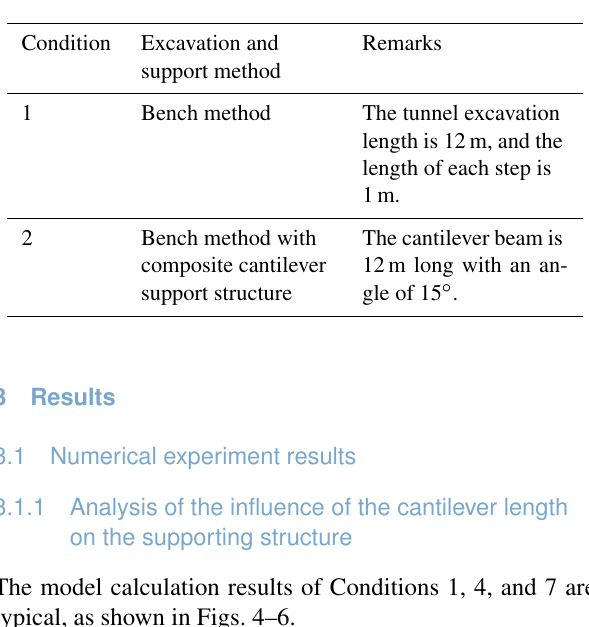
Table 3. Model calculation